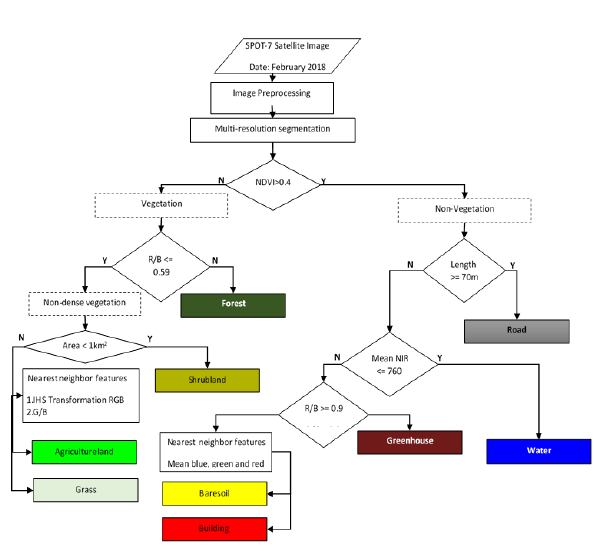
Figure 3. Developed decision-tree to classify Worldview2